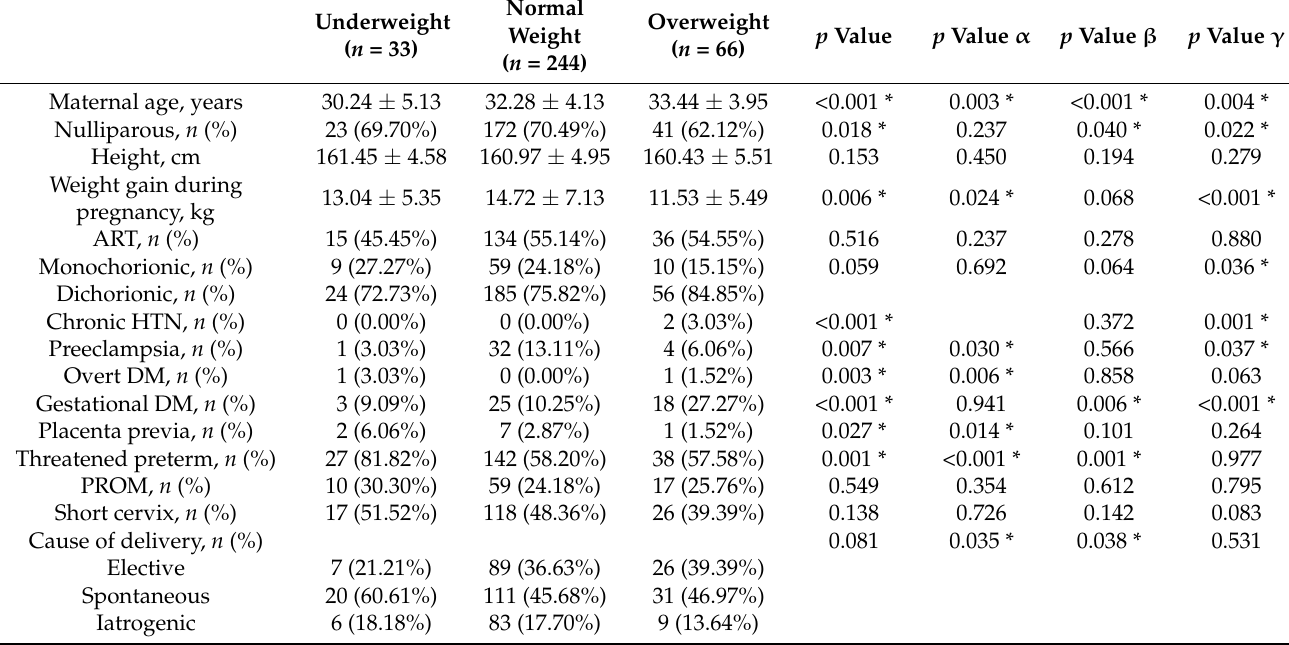
Table 1. Maternal characteristics and pregnancy-related complications according to maternal pre- pregnant BMI in twin